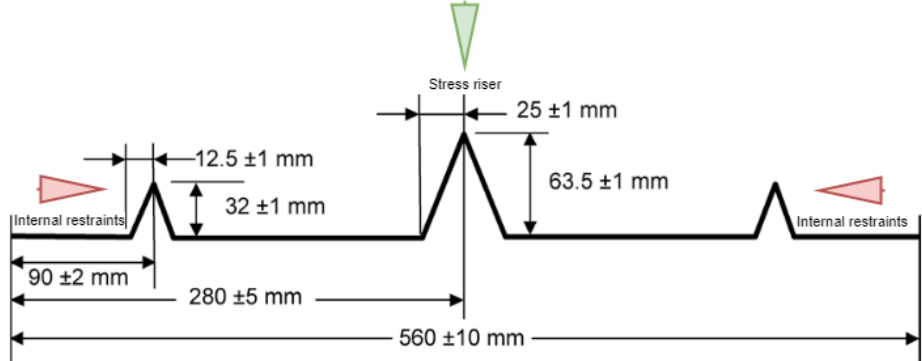
Figure 9. Geometry of the stress riser and internal restraints.